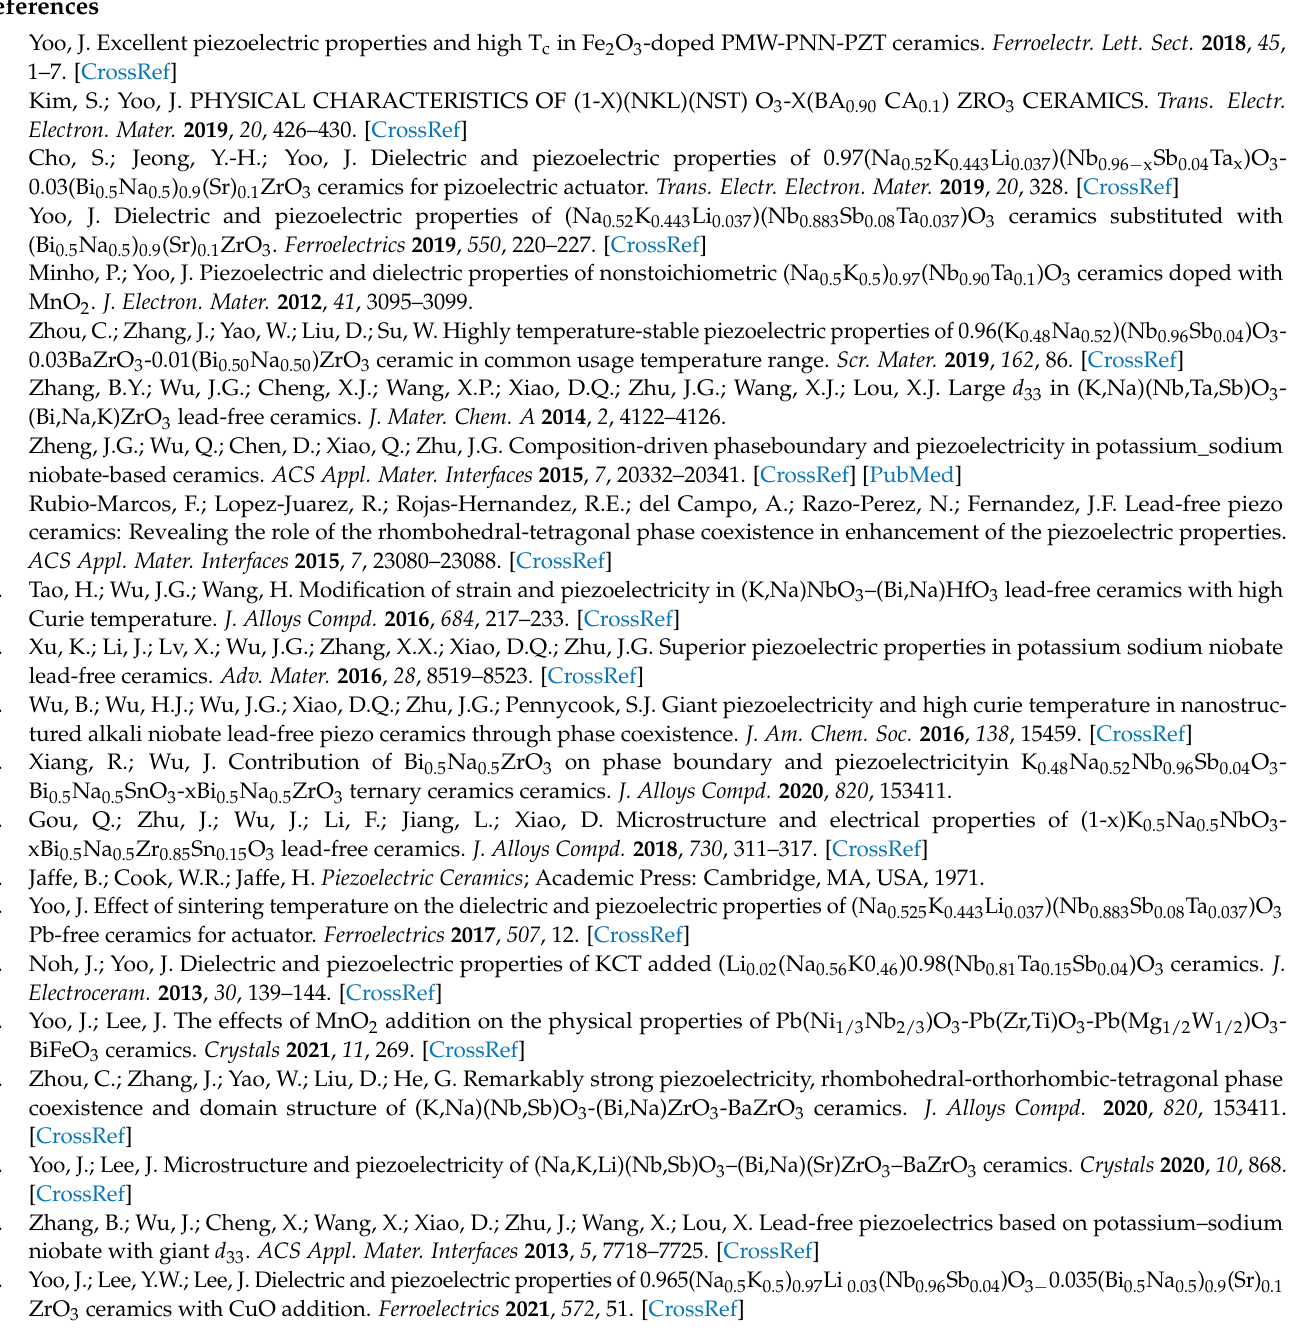
4. The x = 0.07 sample sintered at 1060 ◦ C presented the best electrical characteristics: bulk density = 4.488 g/cm 3 , d 33 = 330pC/N, k p = 0.427, Q m = 61, and ε r = 2521. We believe that the x = 0.07 sample is the best material for piezoelectric